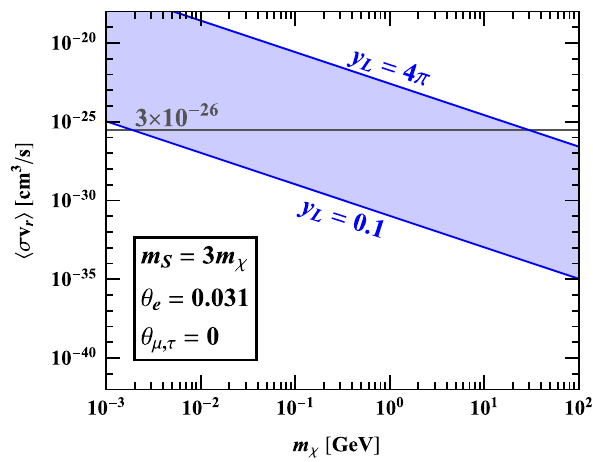
Fig. 2 Thermallyaveragedannihilationcrosssectionmultipliedbythe relative velocity for χχ → νν . We have fixed m S = 3 m χ , θ e = 0 . 031, θ μ = θ τ = 0, and varied y . 1 and 4 L between 0